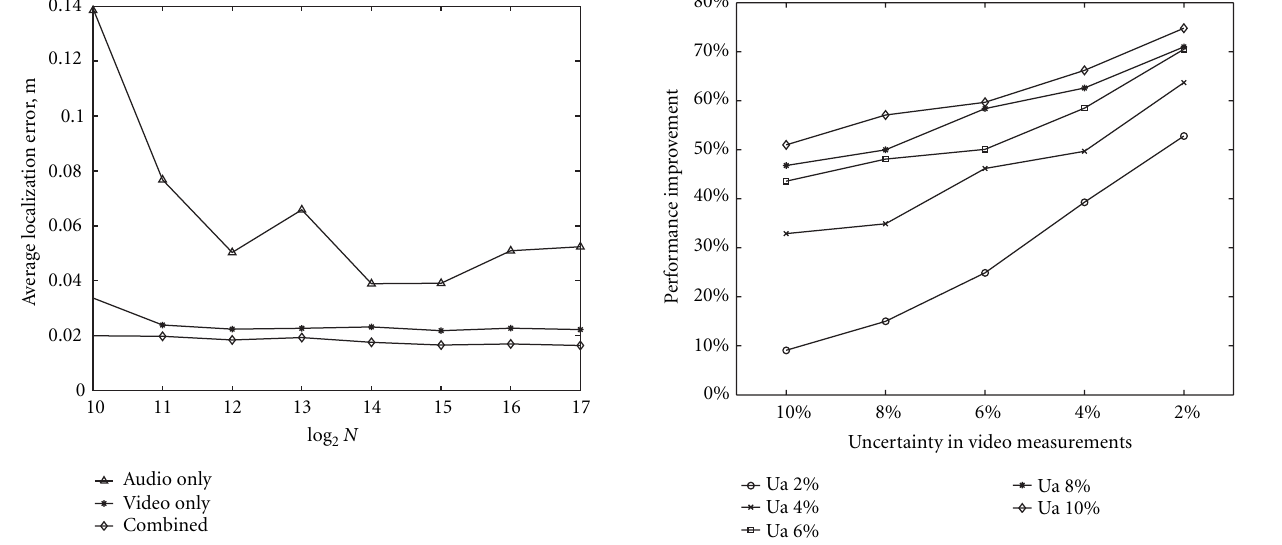
Figure 3: Plot of the percentage improvement in the performance of audio-video tracker versus the performance of audio-only tracker for di ff erent combinations of audio and video measurement uncer-